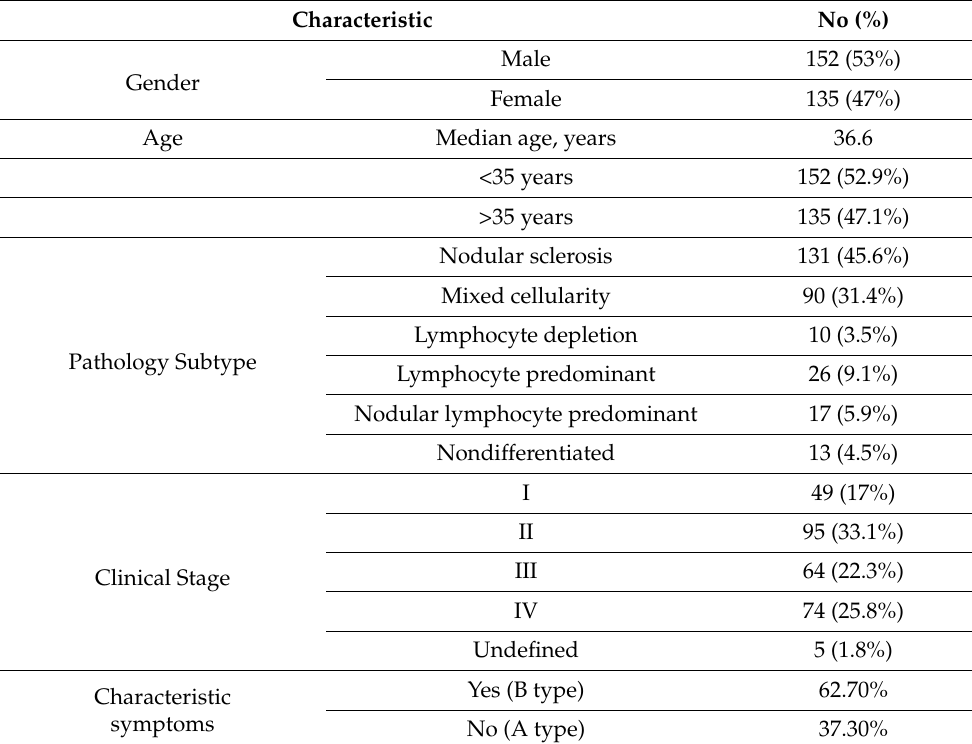
Table 1. Patient